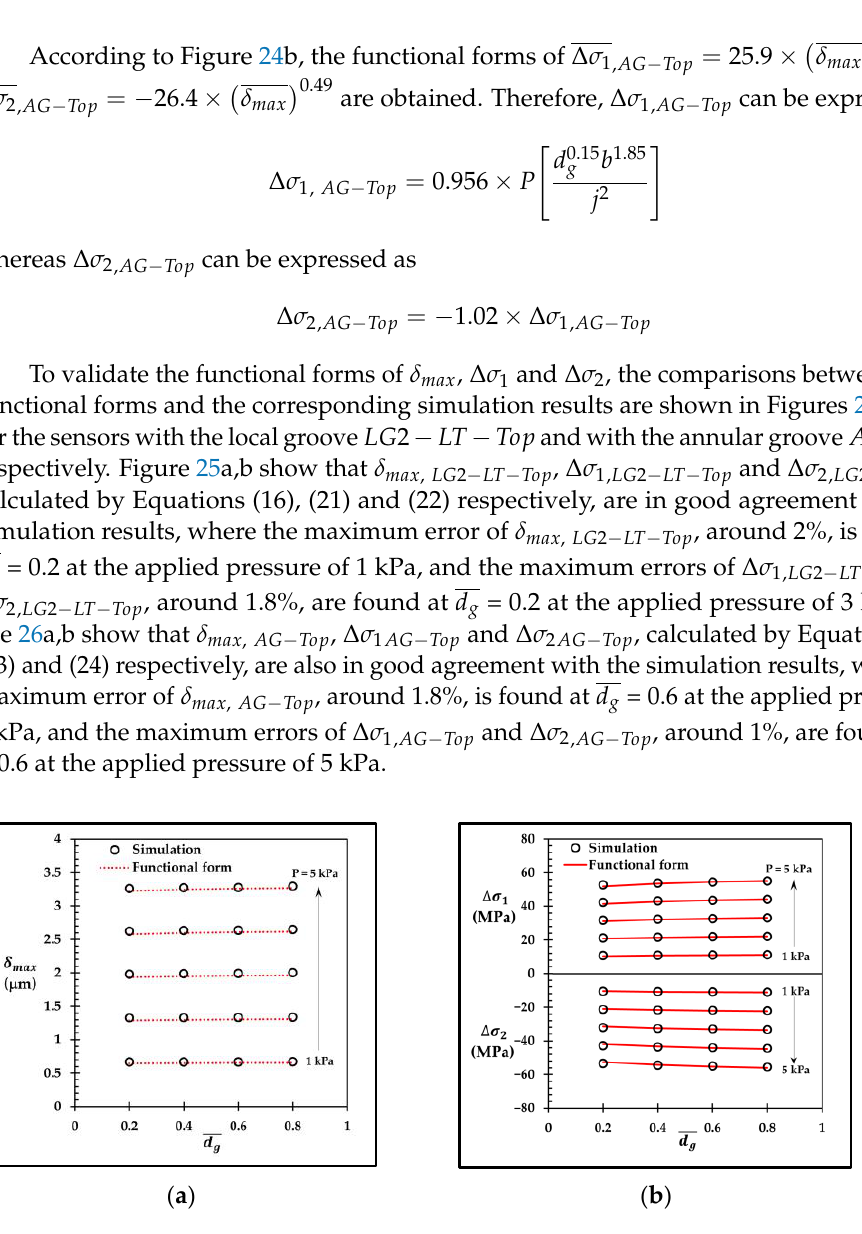
Figure 26. Comparisons of simulation results with ( a ) functional form of maximum deflection 𝛿 𝑚𝑎𝑥,𝐴𝐺2−𝑇𝑜𝑝 and ( b ) functional forms of averaged stress differences ∆𝜎 1 The functional forms of the averaged stress differences in terms of 𝑑 𝑔 in Equations (21) – (24), i.e., ∆𝜎 1,𝐿𝐺2−𝐿𝑇−𝑇𝑜𝑝 , ∆𝜎 2,𝐿𝐺2−𝐿𝑇−𝑇𝑜𝑝 , ∆𝜎 1,𝐴𝐺−𝑇𝑜𝑝 and ∆𝜎 2,𝐴𝐺−𝑇𝑜𝑝 , respectively, can be used to calculate 𝑉 𝑜𝑢𝑡,𝑖 by substituting ∆𝜎 1 and ∆𝜎 2 in the case study of interest into Equation (13). Therefore, sensitivity can be calculated by substituting 𝑉 𝑜𝑢𝑡,𝑚𝑎𝑥 into Equa- tion (4) while nonlinearity error can be calculated by substituting 𝑉 𝑜𝑢𝑡,𝑖 and 𝑉 𝑜𝑢𝑡,𝑚𝑎𝑥 into Equation (14).